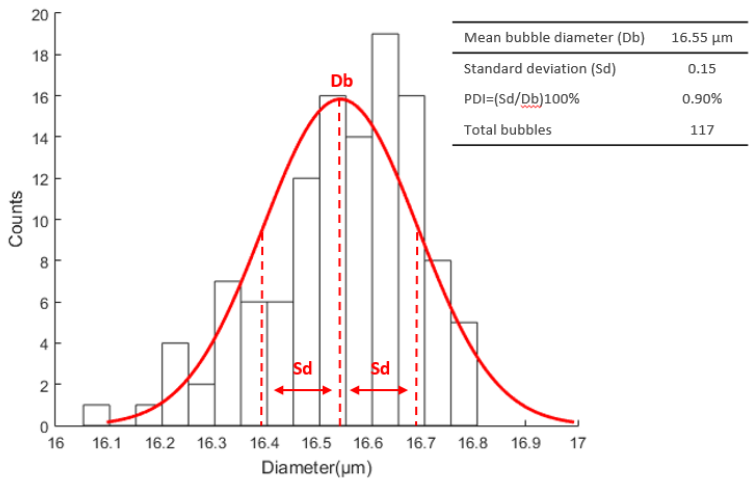
Figure 7. Microbubbles’ diameter distribution curve, using the MIC-SLM-30 micropipette.